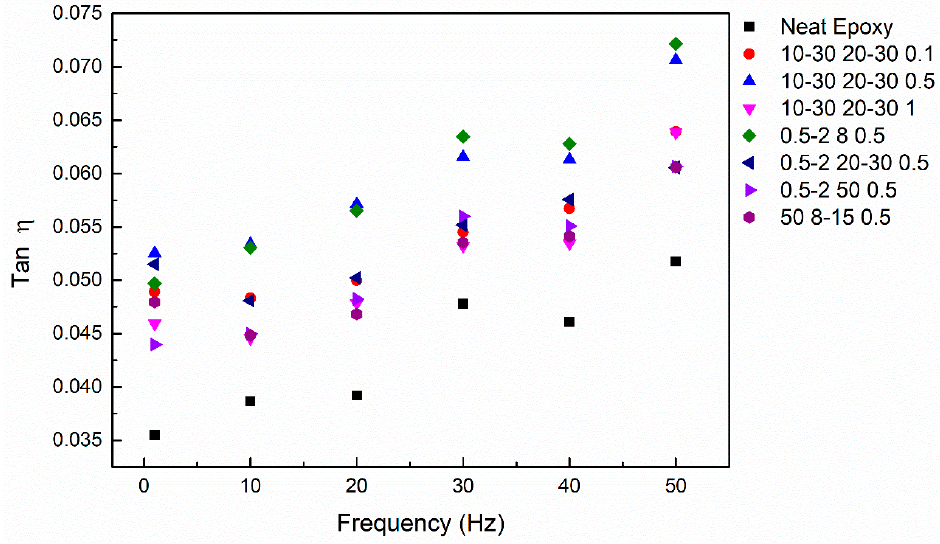
Figure 5. Loss factor of all samples at the frequency range of 1–50 Hz.